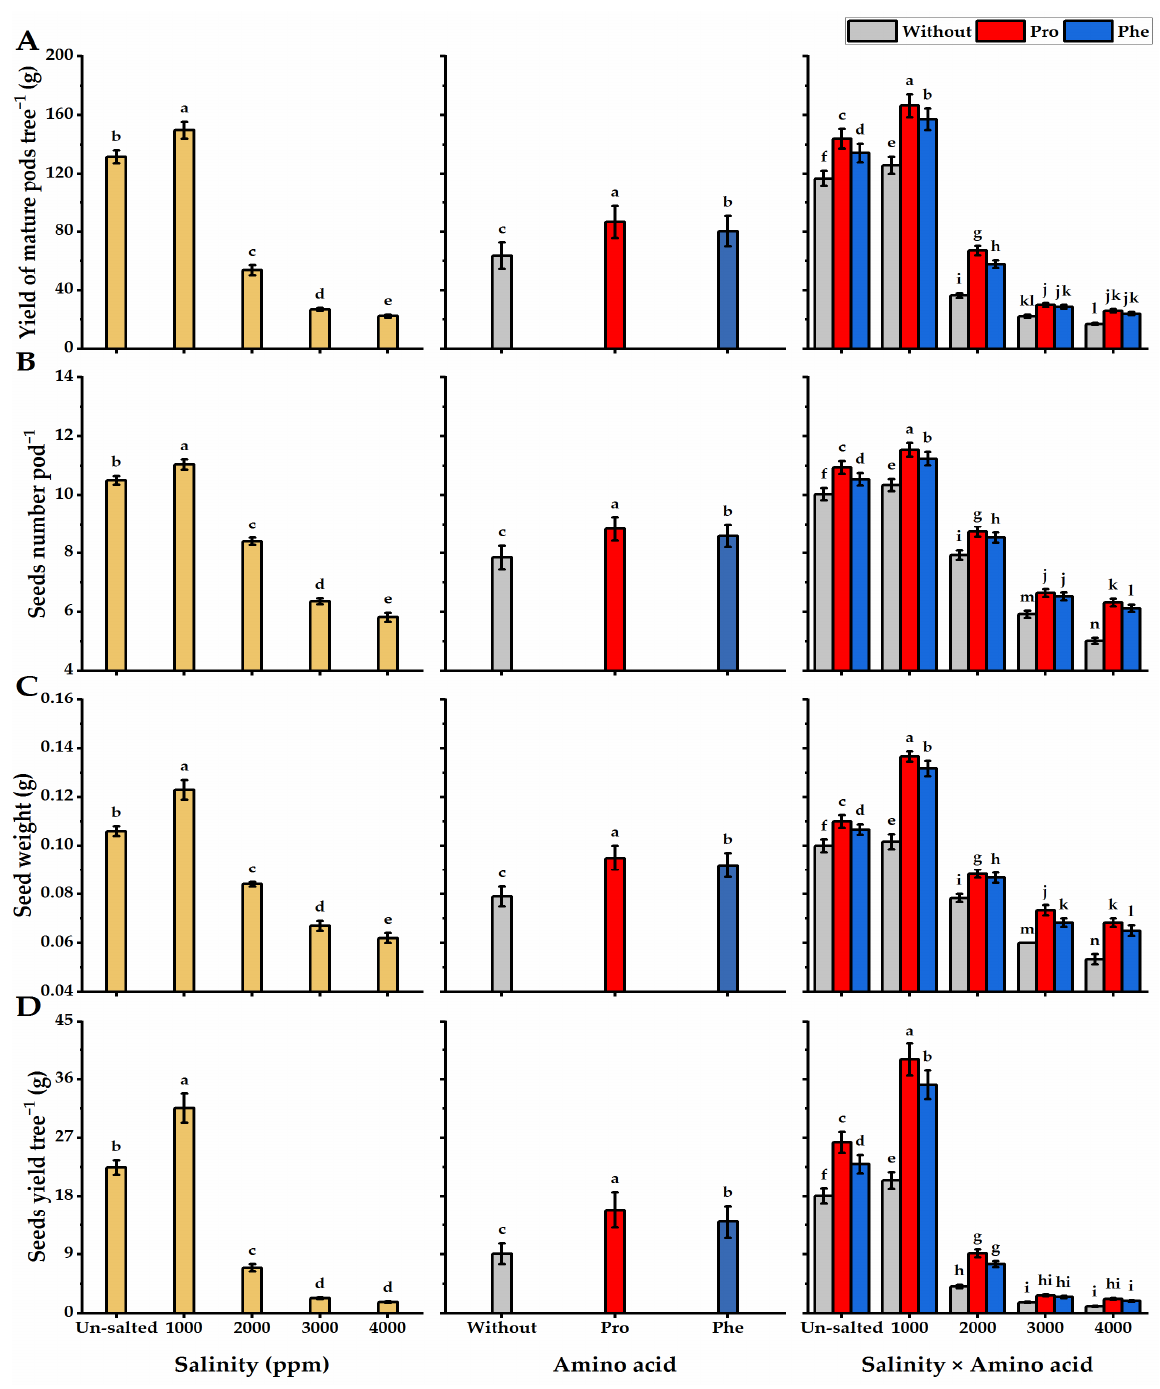
Figure 4. Influence of exogenous spray treatments of proline (Pro) or phenylalanine (Phe) on ( A ) yield of mature pods tree − 1 , ( B ) seeds number pod − 1 , ( C ) seed weight, and ( D ) seed yield tree − 1 of moringa trees cultivated under different levels of salinity. Data are mean value ± SE. Bars with different letters are significantly different at p ≤ 0.05 level .